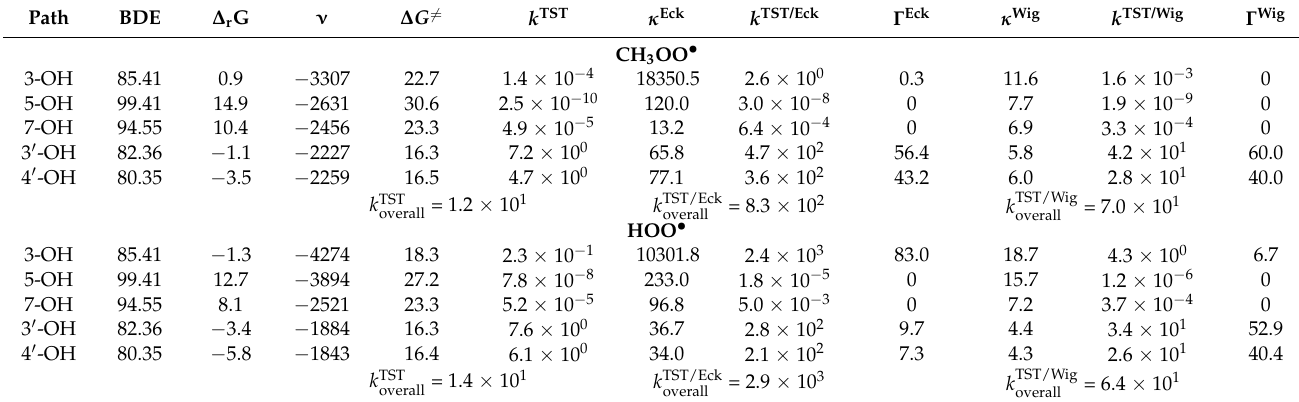
Table 1. Bond dissociation enthalpy (BDE) (kcal/mol), reaction Gibbs free energy ∆ r G (kcal/mol), TS imaginary frequency ν (cm − 1 ), Gibbs free energy of activation ∆ G (cid:54) = (kcal/mol), TST rate constant k